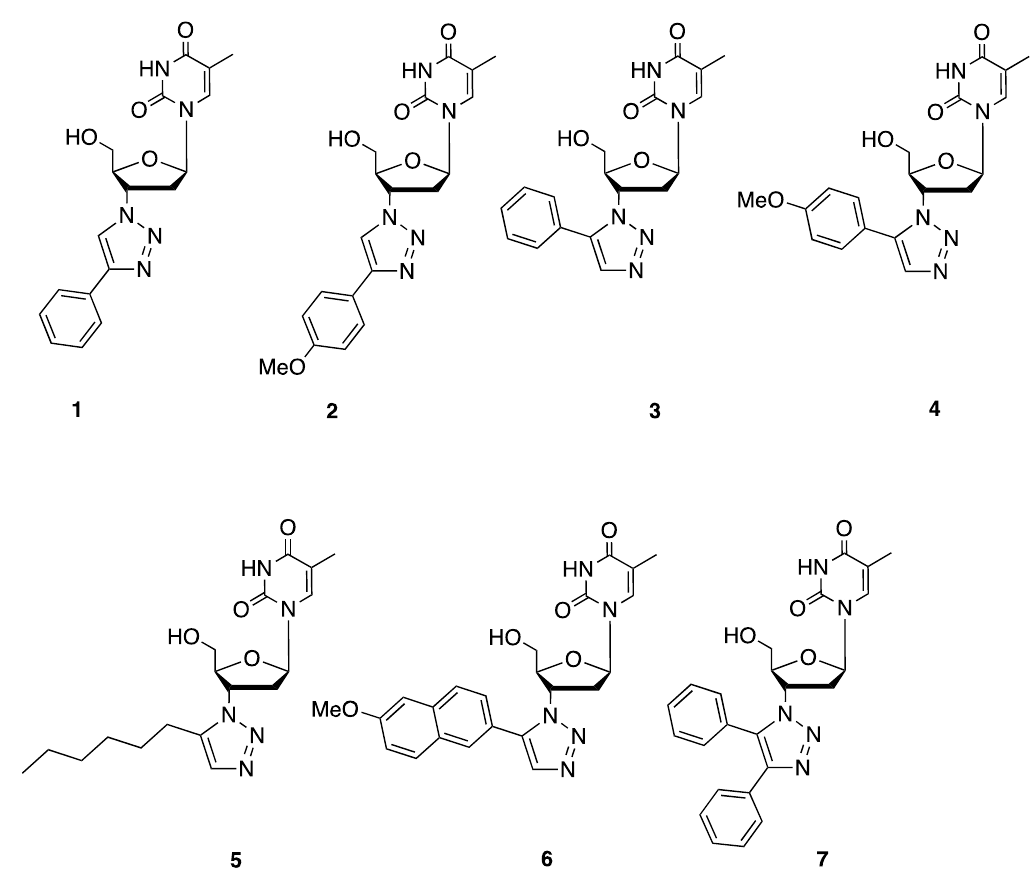
Figure 1. Representative 1,4- and 1,5-triazoles synthesized in this work, compounds 1 – 7 .